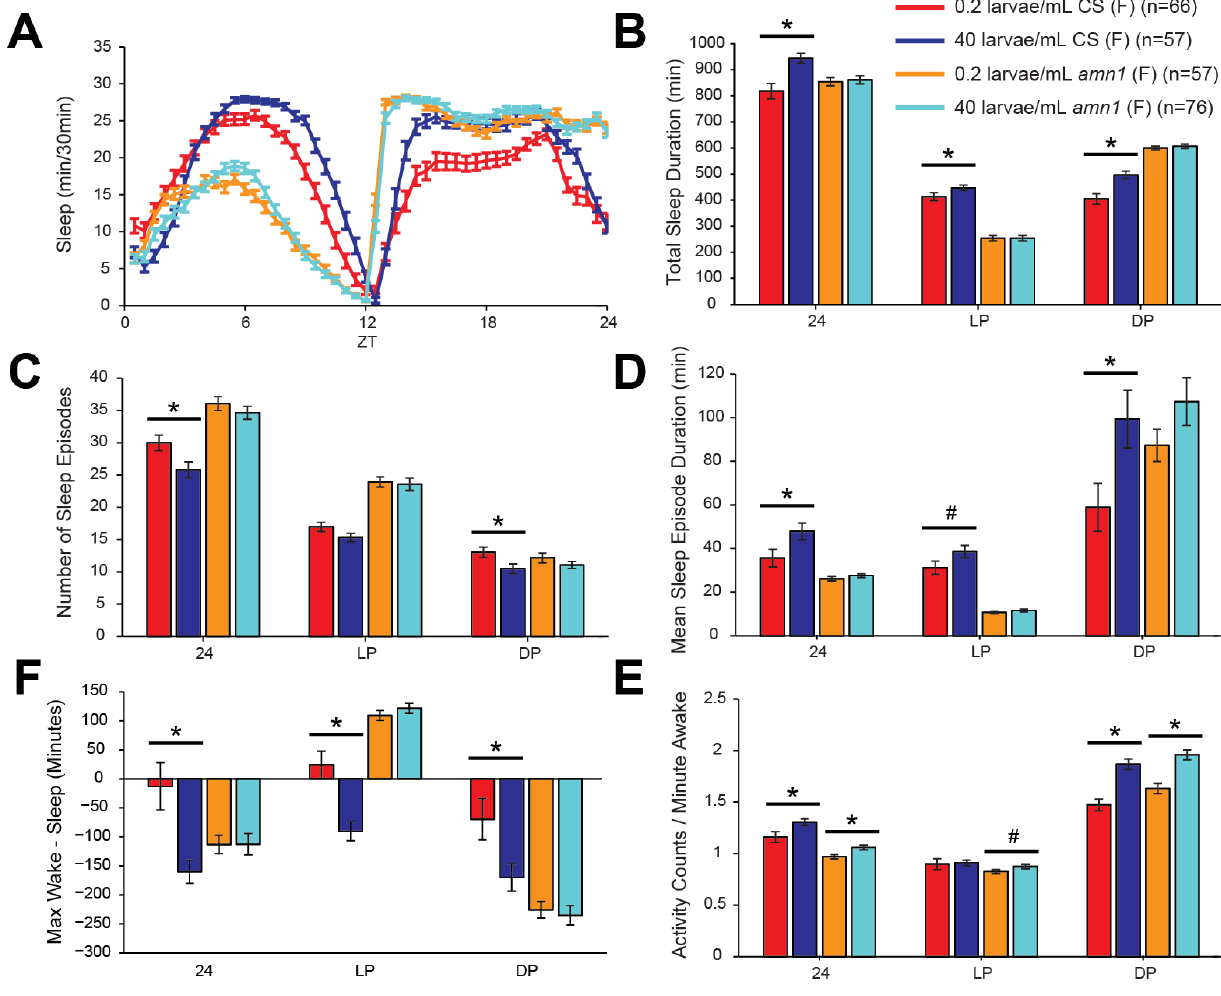
Figure 3. Mutation of the gene amnesiac blocked the effects of larval population density on adult sleep in female flies. ( A ) Minutes of sleep per 30-min bin, across an average day consisting of 12 h of light followed by 12 h of darkness (LD). Time after lights-on is indicated by zeitgeber time (ZT) on the X -axis. ( B – F ) Quantification of sleep parameters for the same average LD day, across all 24 h, across the light period (LP), or across the dark period (DP). Error bars represent the standard error of the mean. n represents the number of flies in each group. * Indicates p < 0.05 for a comparison of the two bars under the line. # Indicates 0.05< p < 0.10. ( B ) Total sleep duration. ( C ) Number of sleep episodes. ( D ) Mean sleep episode duration. ( E ) A metric for relative stability of wake and sleep states, calculated by subtracting the duration of the longest sleep episode from the duration of the longest wake episode. Thus, positive values indicate that wakefulness was more consolidated than sleep, and vice versa . ( F ) Total number of beam crosses, or activity counts, per minute of wakefulness. The promotion of sleep consolidation seen with increased larval population density in CS flies was inhibited in amn 1 flies. In contrast, larval density was associated with hyperactivity while awake during the dark period, and this effect was not mitigated by mutation to